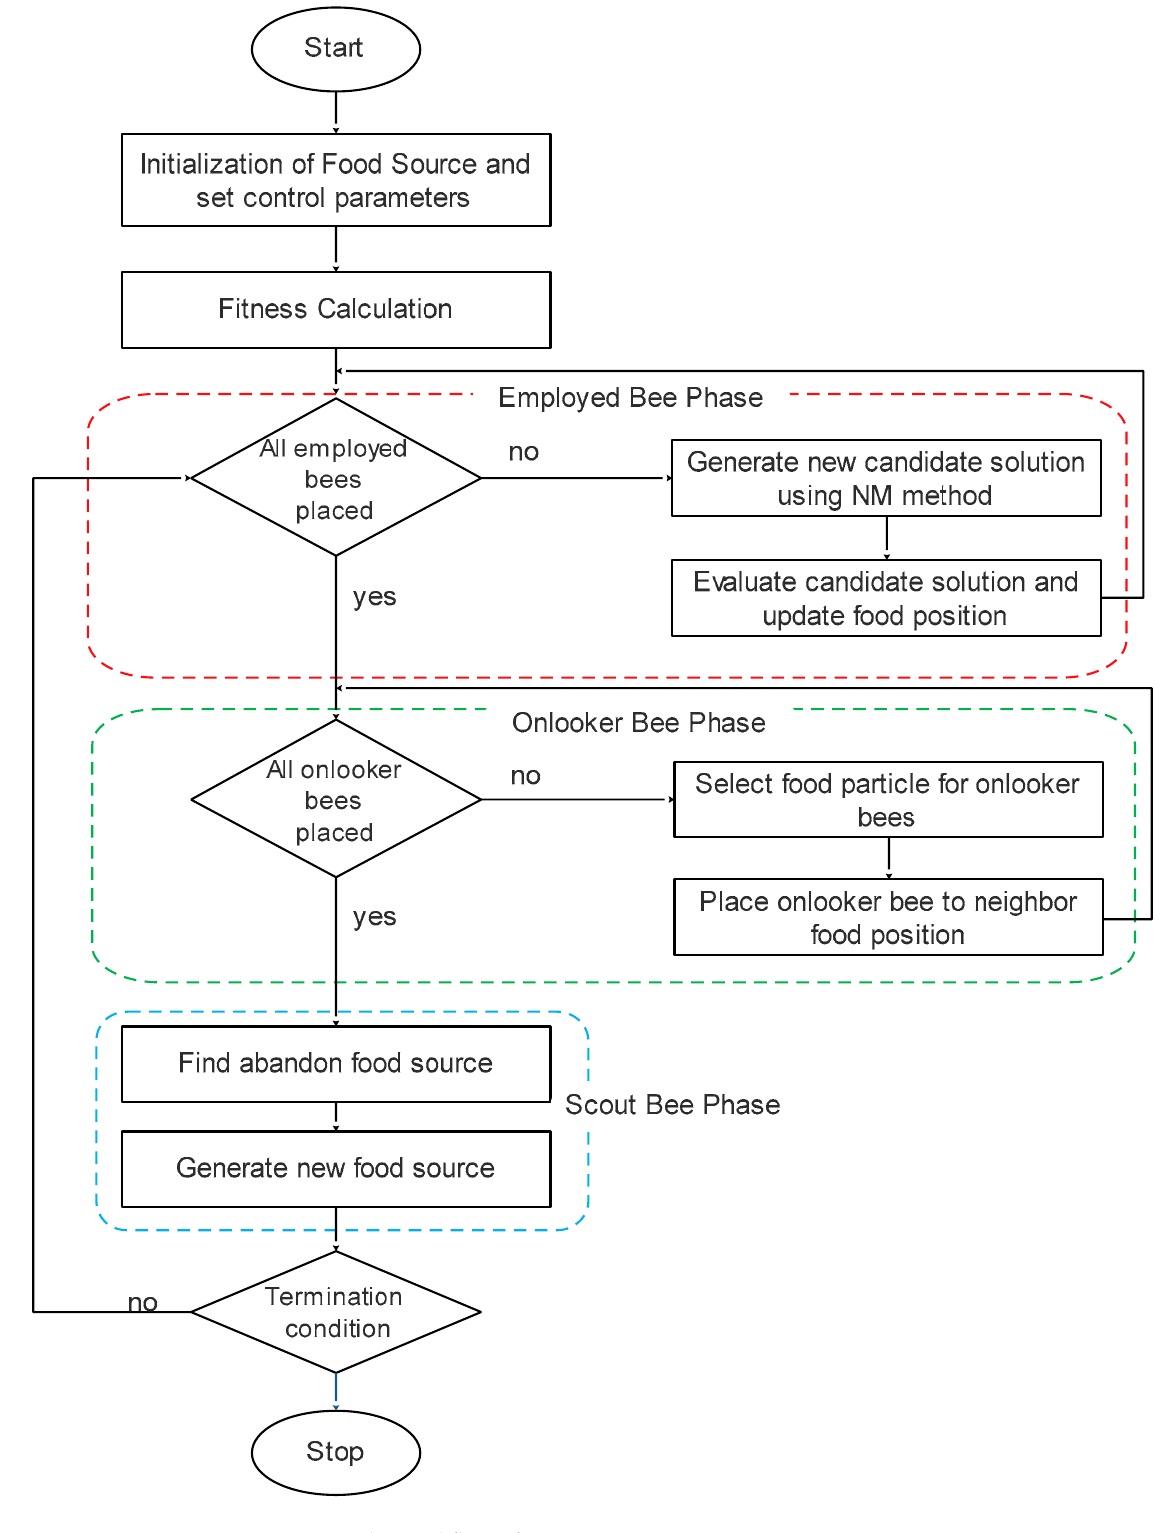
Figure 2. The workflow of NM-ABC. NM method is used in the onlooker bee phase of the ABC algorithm. The intention is to use the NM method in the onlooker bee phase instead of the employee bee phase since the individuals participating in the onlooker bee phase are selected based on probability. When the individual is chosen with probability, it is considered a quality individual